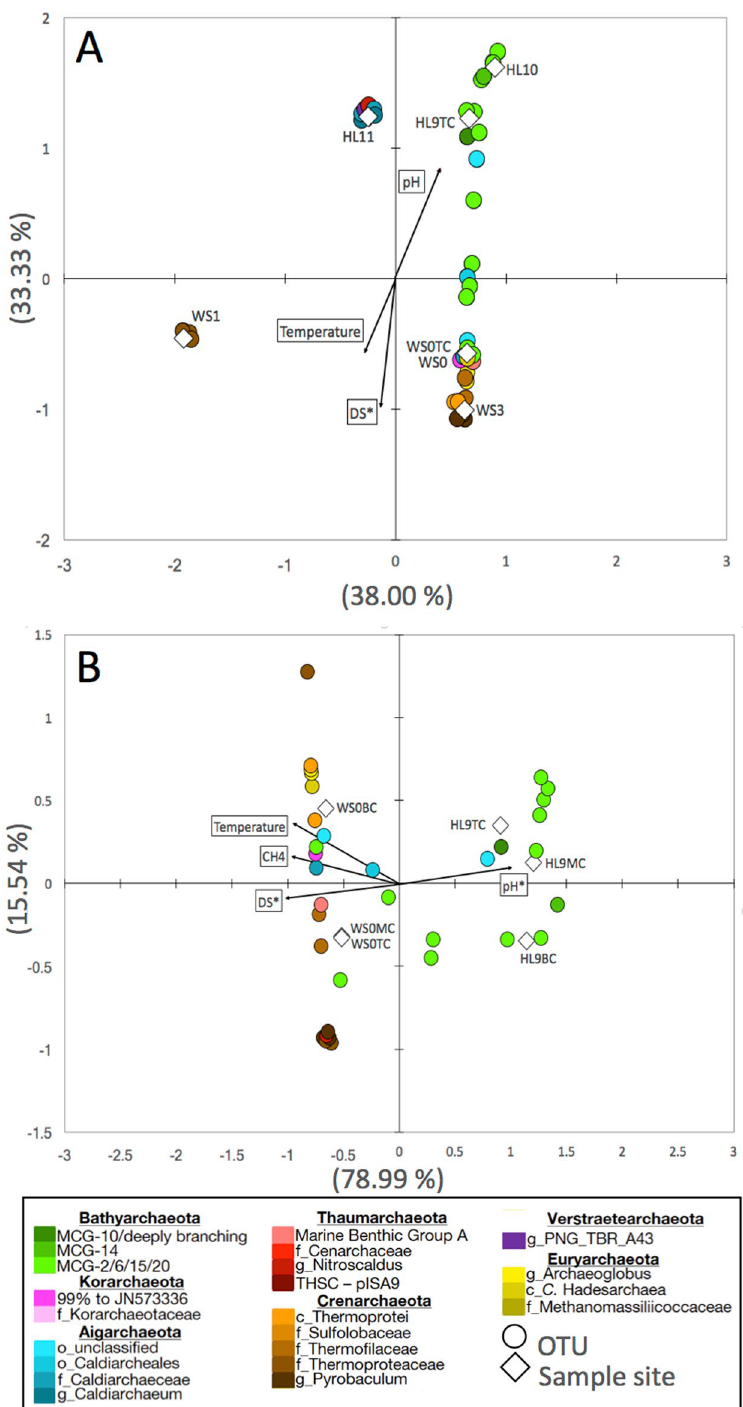
Figure 3. Canonical Correspondence Analyses of phylogenetic distribution and major geochemical parameters. Surface samples are compared to temperature, pH, dissolved sulfide (DS) and plotted with OTU distribution ( A ). Top, middle, and bottom sediment layers from core samples are compared to temperature, pH, DS, and porewater CH 4 concentrations and plotted with OTU distribution ( B ). OTUs representing > 0.5% sequence abundance are indicated by circles. Colors correspond to those in Fig. 1. White diamonds indicate sample sites. Black arrows indicate physicochemical